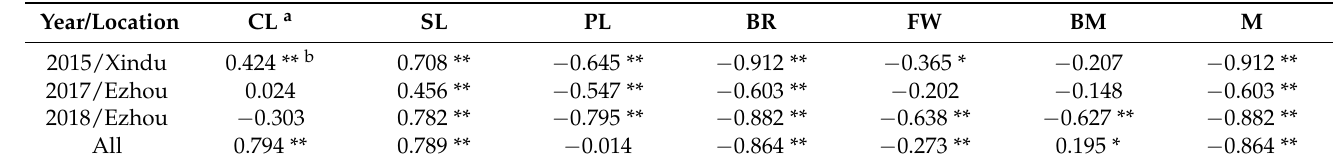
Table 5. Analysis of the correlations between the relative value of lodging-related traits of twelve indica rice cultivars and the T mean during the determined growth durations on the three sowing dates of different years and on all the sowing dates across two locations and three years.